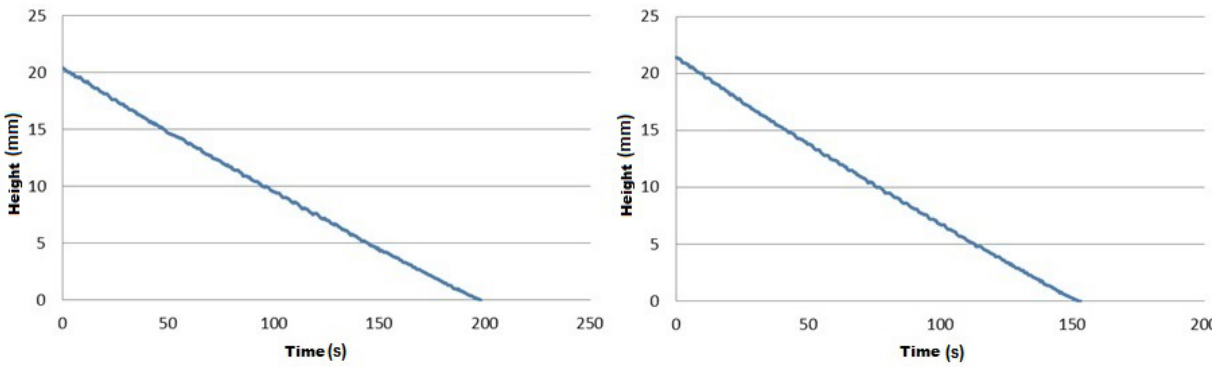
Figure 7. Outflow experiments with an attached outflow channel, tube inner diameter 1.5 mm ( left ) and tube inner diameter 1.6 mm ( right